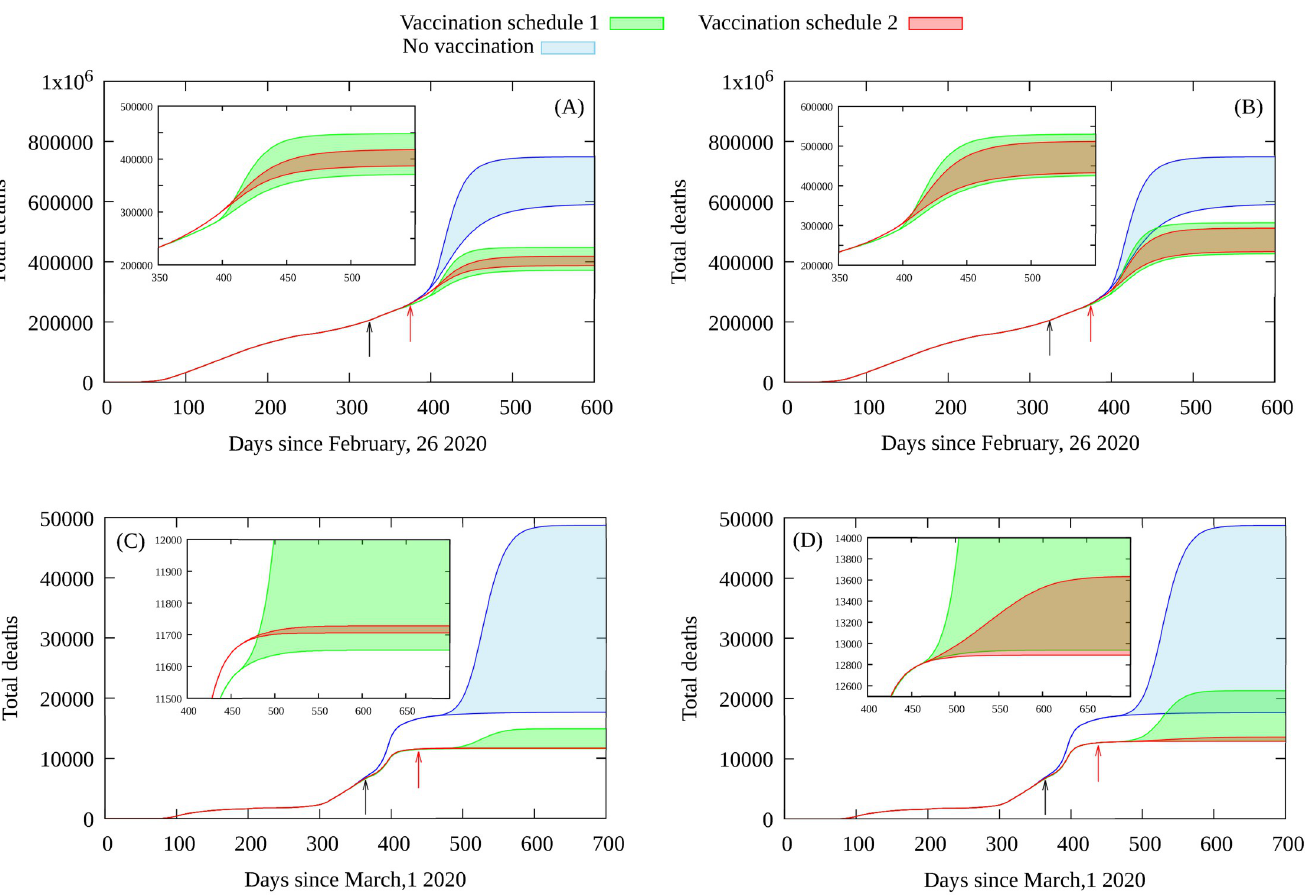
Fig 4. Total number of symptomatic cases: Brazil (A) e superspreaders as described in the main text. The black arrows indicate starting of vaccination and red arrows the moment superspreaders return to full social contact (3 � α � 10). The lower and upper curves defining the green and red shaded areas correspond to α = 3 and α = 10, respectively.